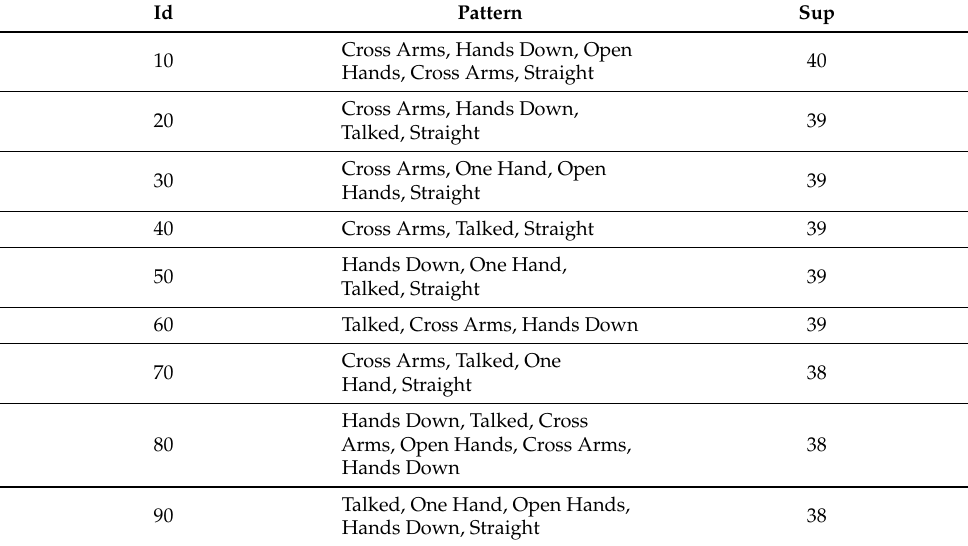
Table 5. Selected sequences from presentation 1 of year 1.